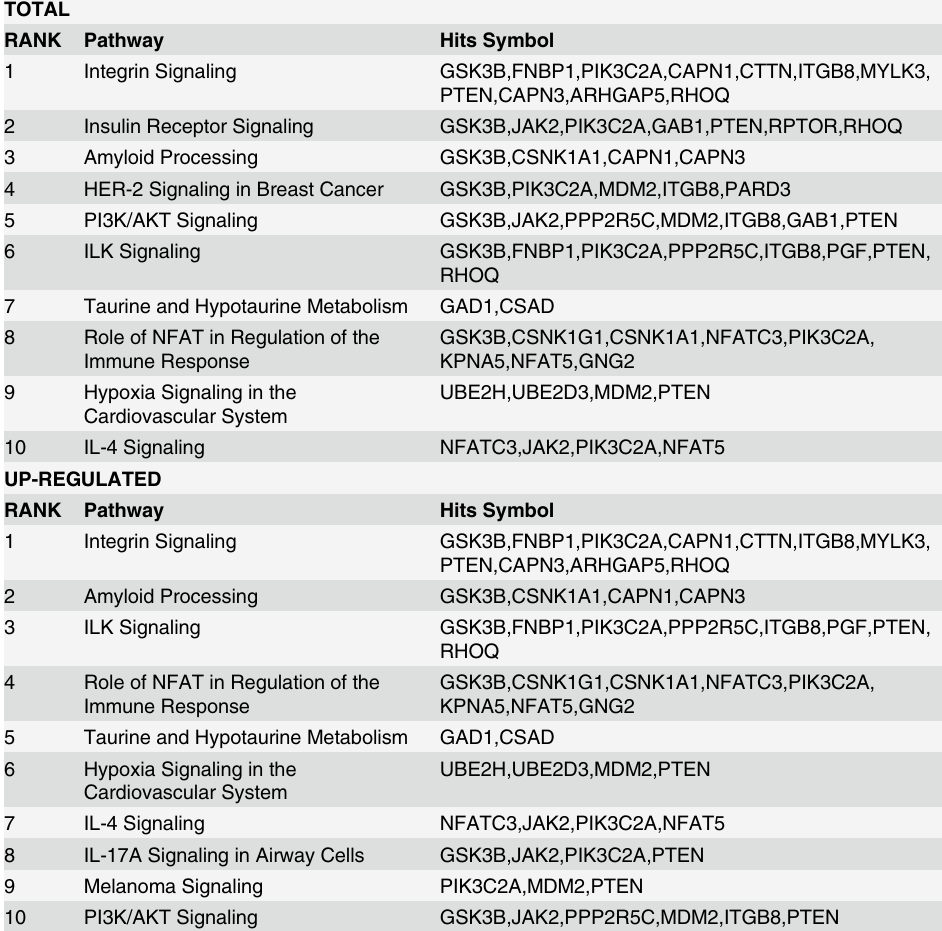
Table 3. TOP 10 list of IPA pathway analysis of DEGs between BPD and control in L neurons.